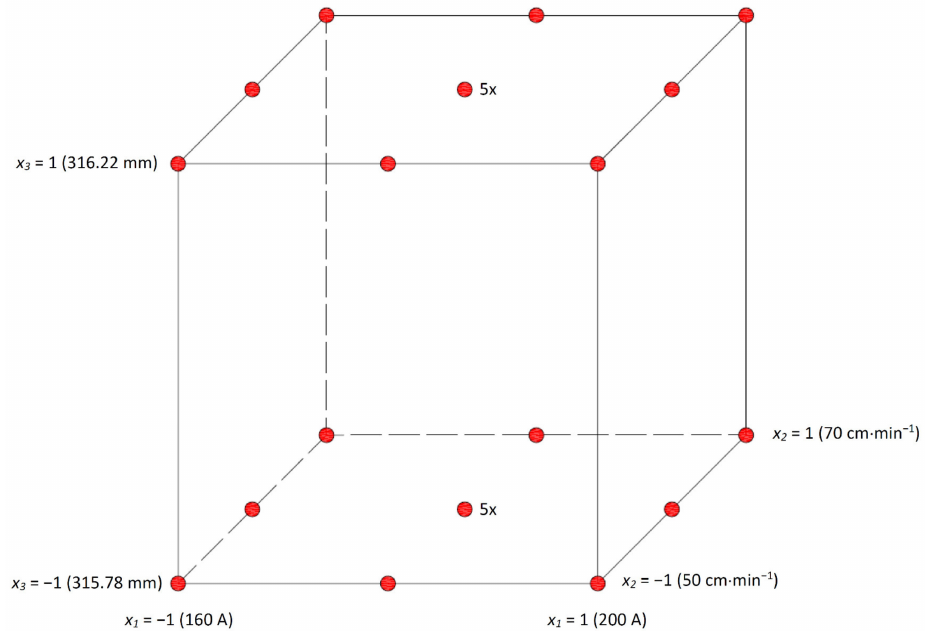
Figure 11. Demonstration of the proposed experiment